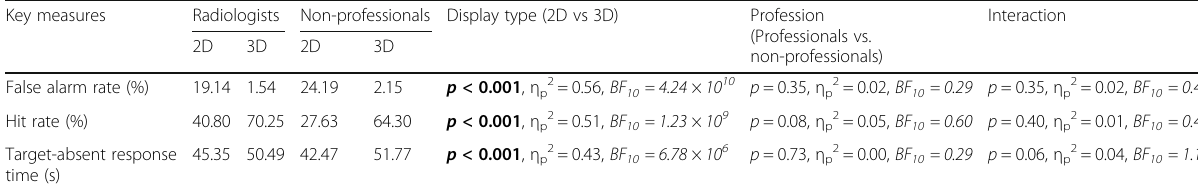
Table 1 Summary of Experiment 1 results for professionals and non-professionals Key measures Radiologists Non-professionals Display type (2D vs 3D) Profession